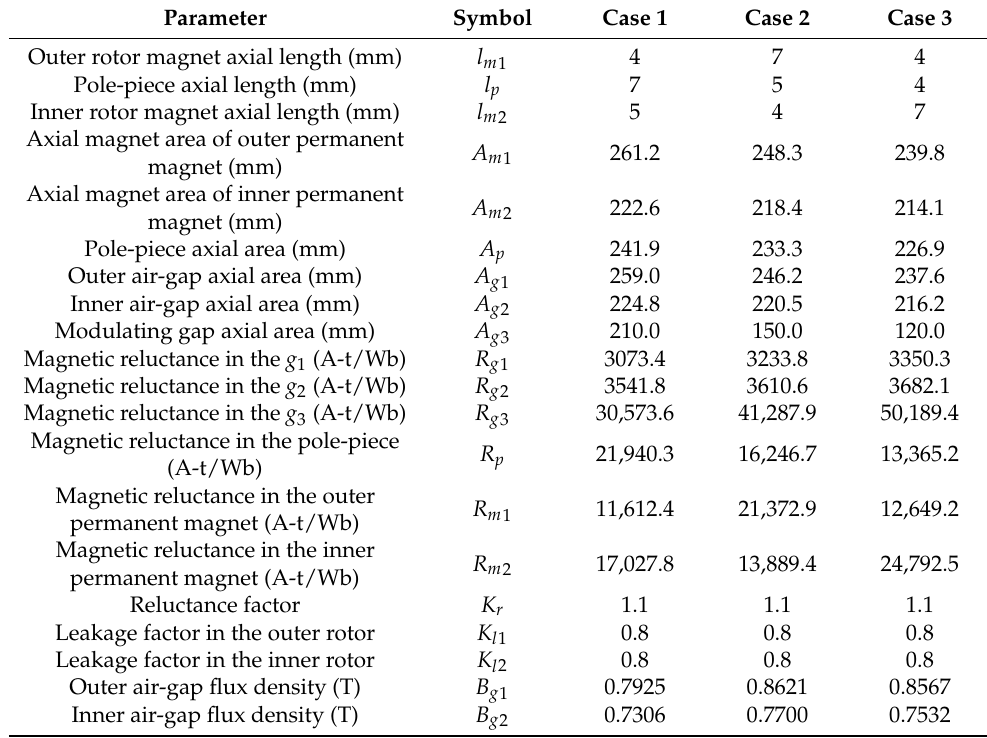
Table 4. Magnetic circuit analysis of three CMGTs by EMC